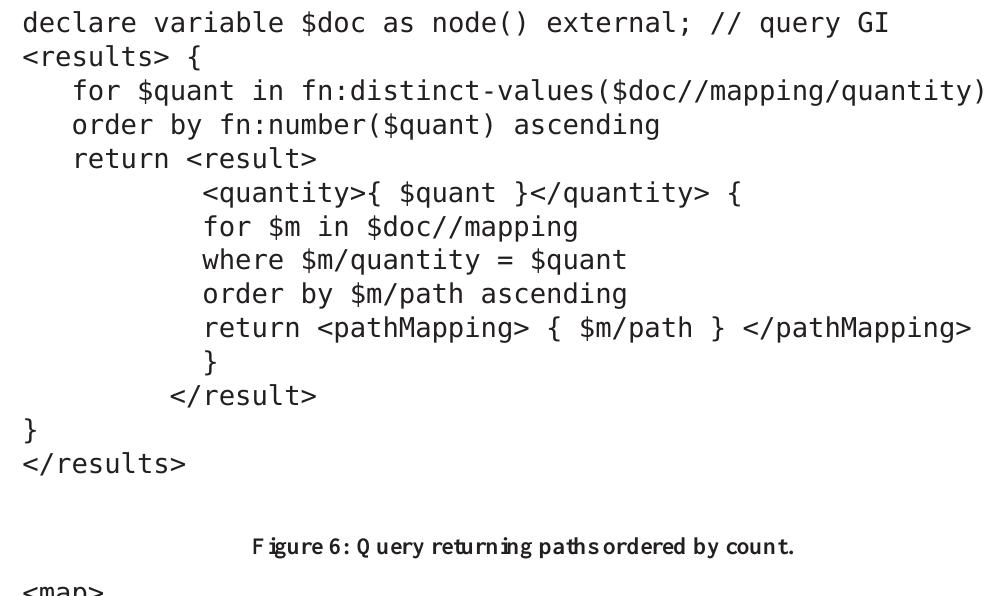
Figure 6: Query returning paths ordered by count.